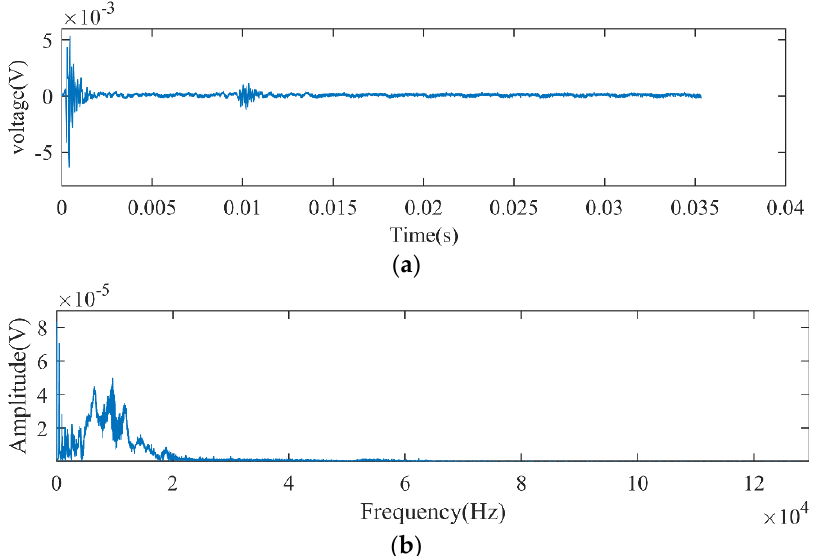
Figure 20. Time domain and frequency domain waveform diagram of noise signal of Yellow River Bridge. ( a ) Signal time domain diagram; ( b ) signal frequency domain diagram.